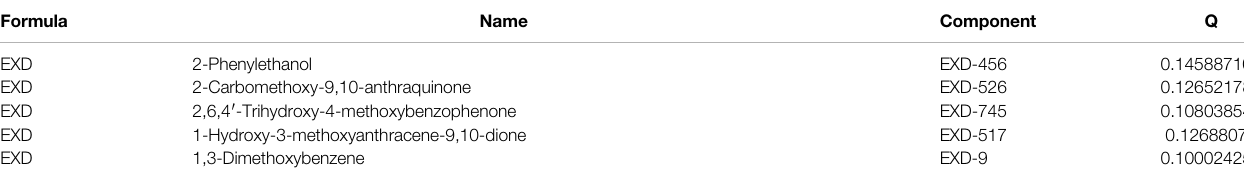
Frontiers in Cell and Developmental Biology |